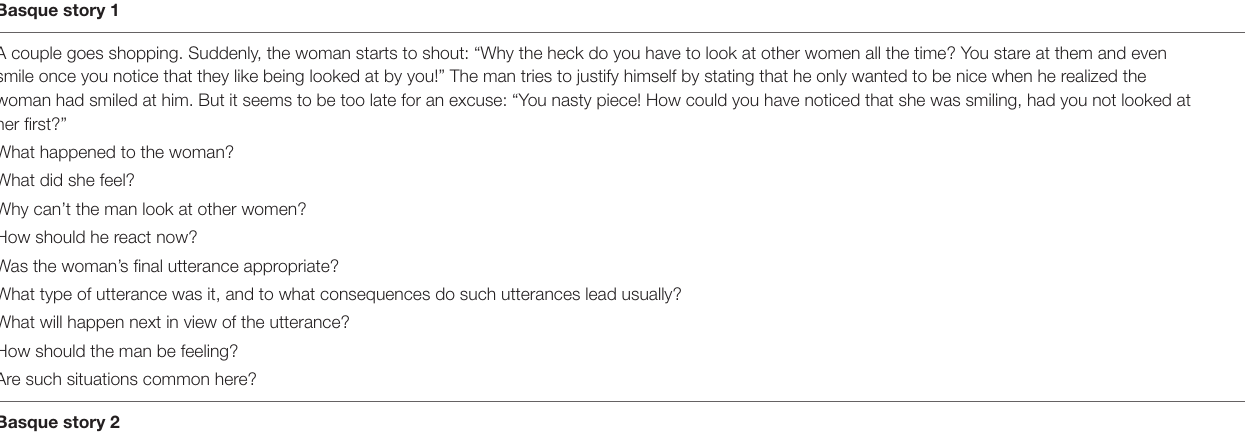
TABLE 2 | Stories on emotions in conflicts. Basque story